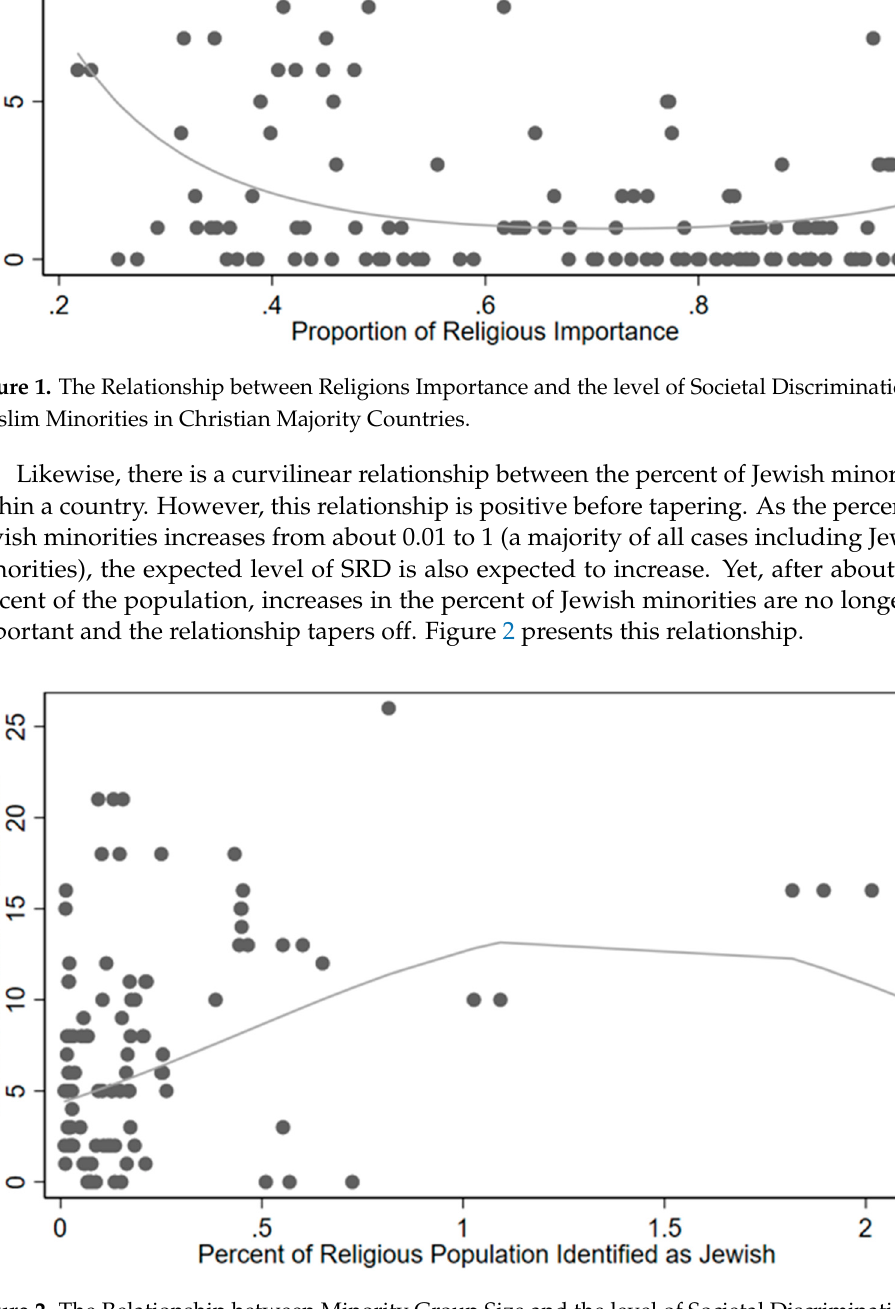
Figure 2. The Relationship between Minority Group Size and the level of Societal Discrimination of Jewish Minorities in Christian Majority Countries.